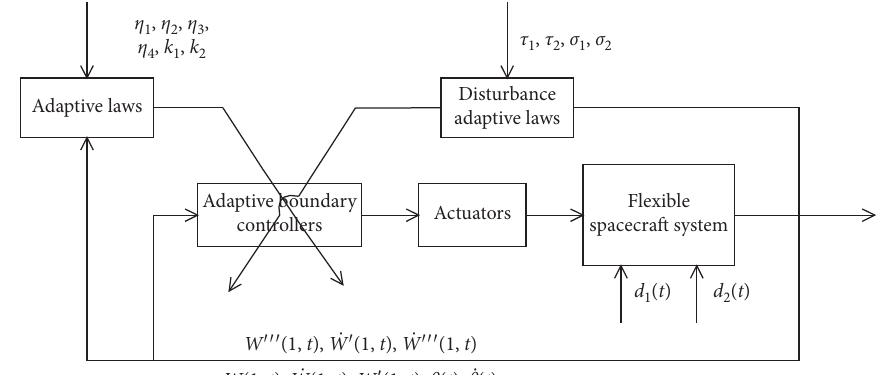
Figure 2: Design procedure of the adaptive boundary control